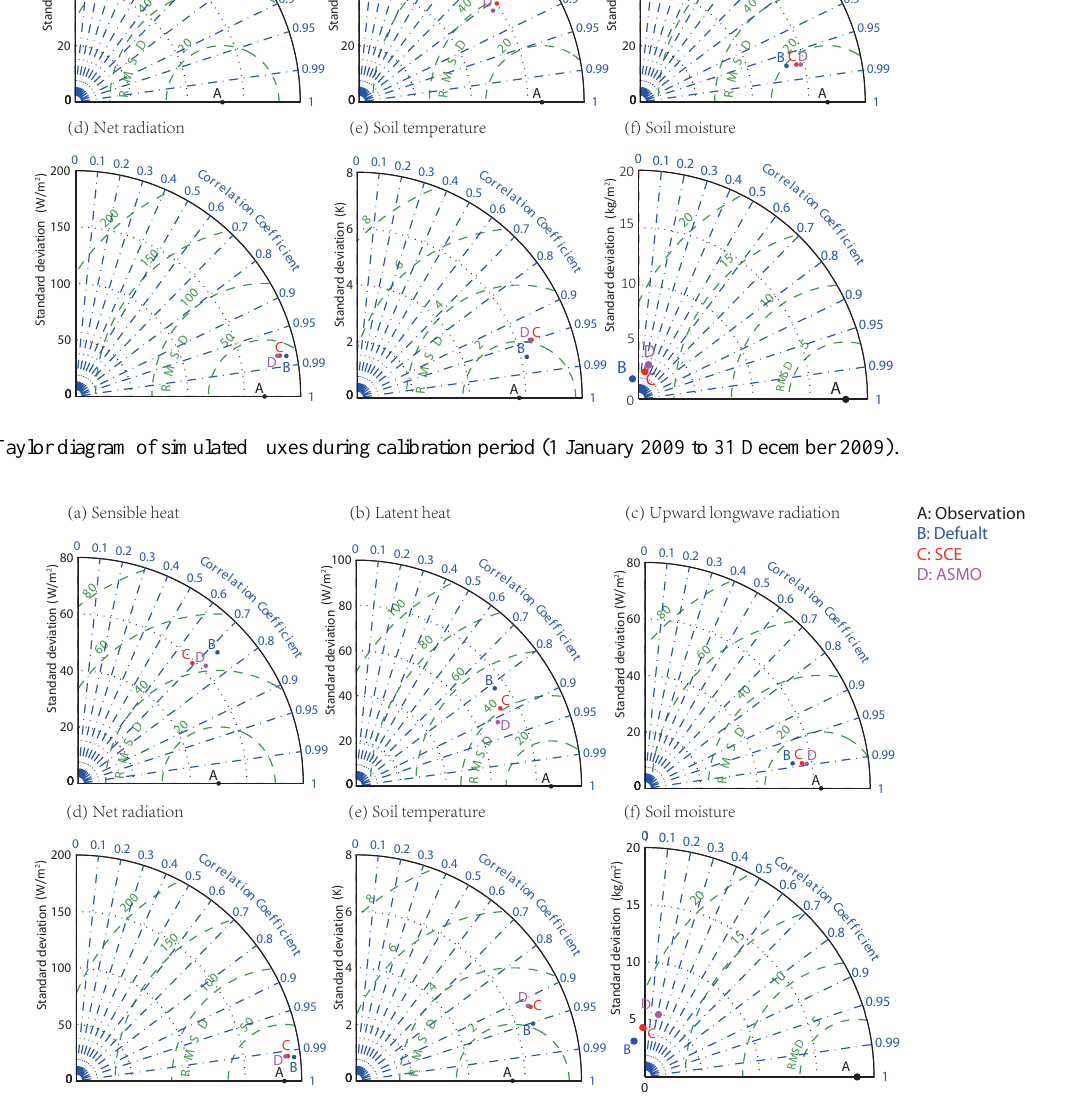
Figure 7. Taylor diagram of simulated fluxes during validation period (here we use the warm-up period as validation period, 1 January 2008 to 31 December